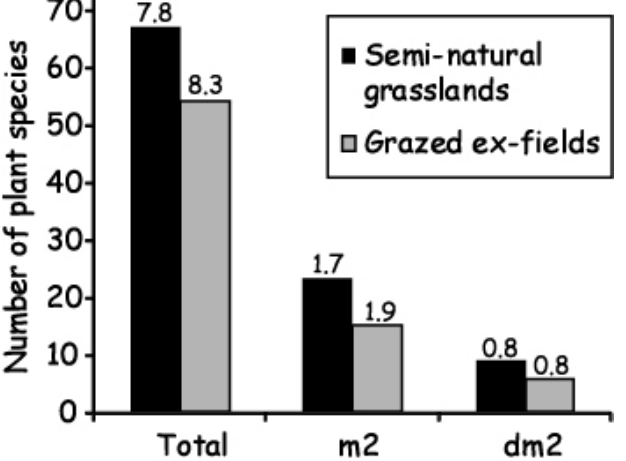
Figure 4. Mean number of plant species found in semi-natural grasslands and grazed ex-arable fields (used as pasture no further back than the 1950s) in south-eastern Sweden. Grasslands in five different landscapes were investigated and total number of plants found in ten 1-m 2 plots within each grassland type per landscape, the mean number of plants per 1-m 2 plot (maximum was 39 species/m 2 ), and five 10 × 10 cm plots within each 1-m 2 plot (500 samples) (maximum was 20 species/dm 2 ). The figure above each bar denotes standard error. Data from